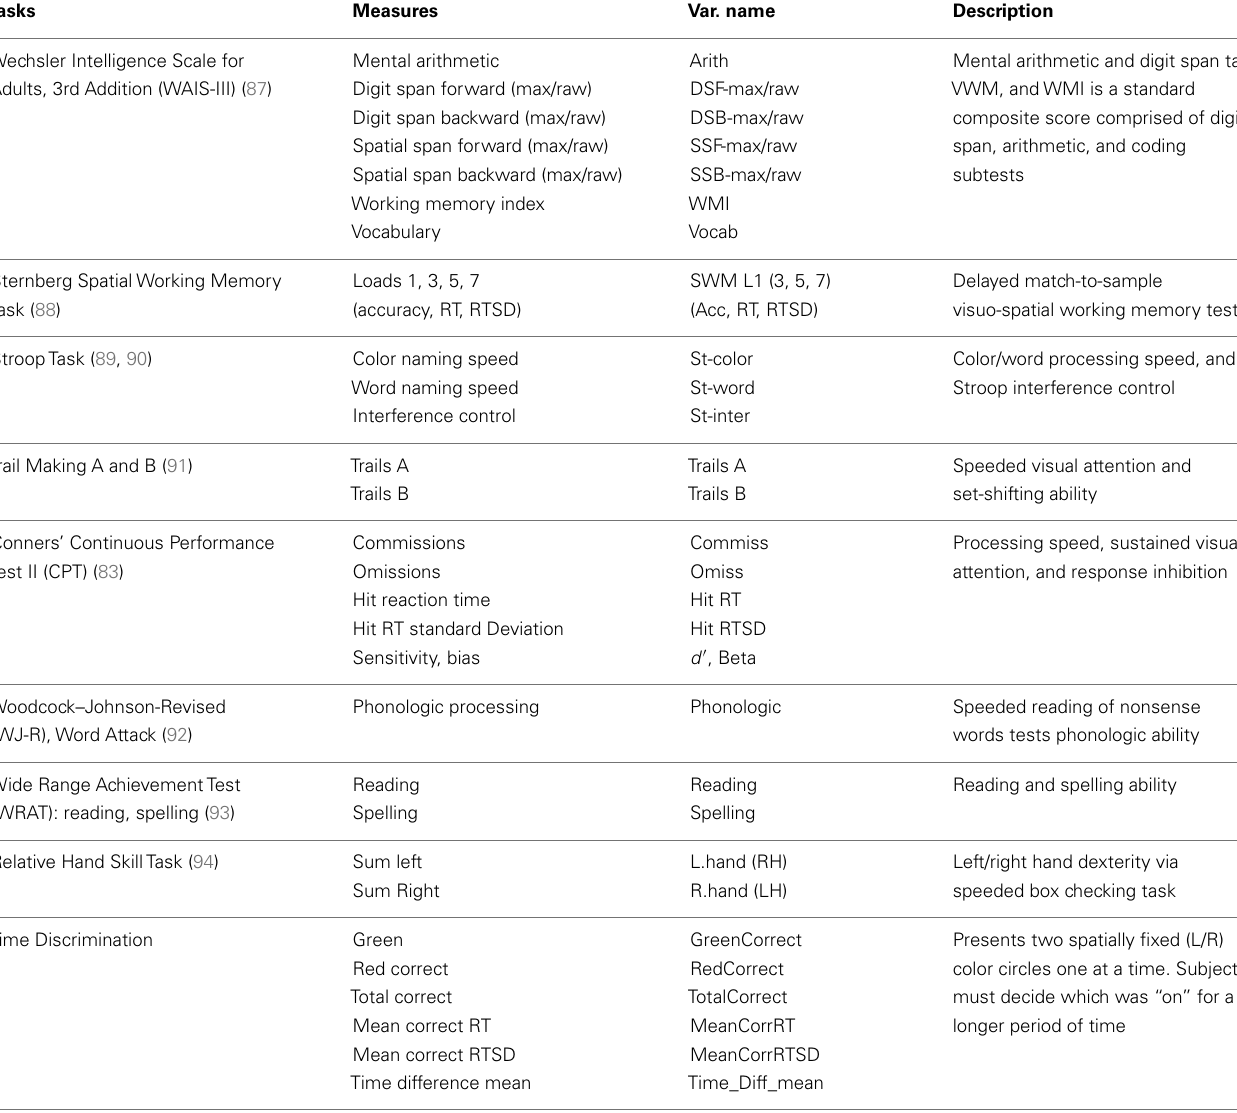
Table 7 | Cognitive measures .